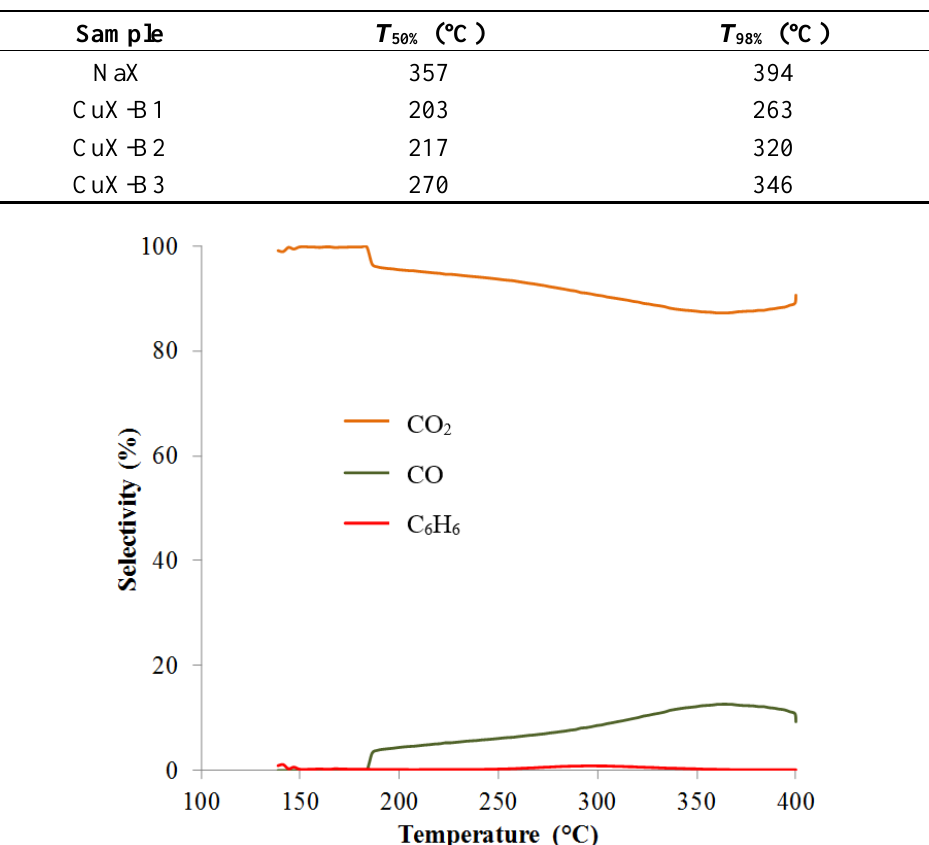
Figure 8. Toluene conversion as a function of the temperature reaction in the presence of different catalysts. Table 5. Catalytic performances of the NaX and copper-exchanged zeolites.